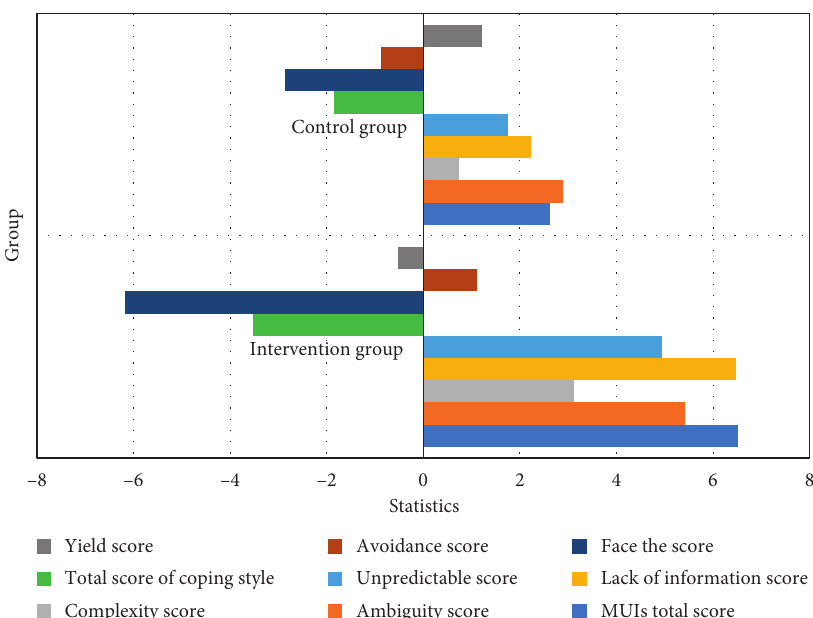
Figure 4: Self-comparison and analysis of uncertainty and coping style of patients in two groups before and after intervention.